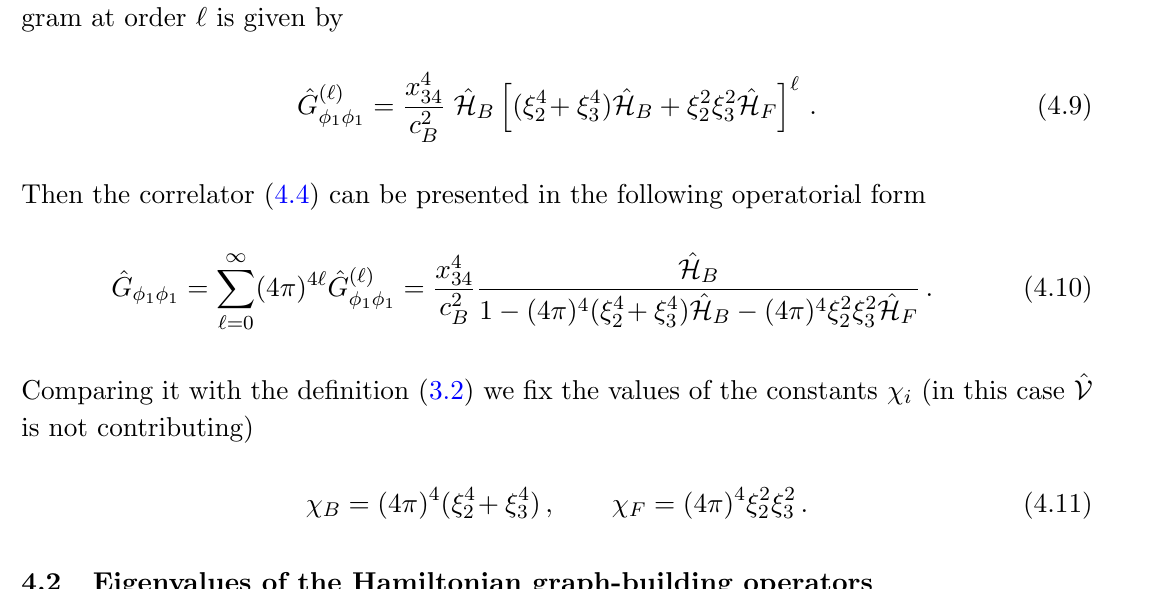
with j = 1 ; 2 ; 3. White dots represent 1 (cid:30) 1